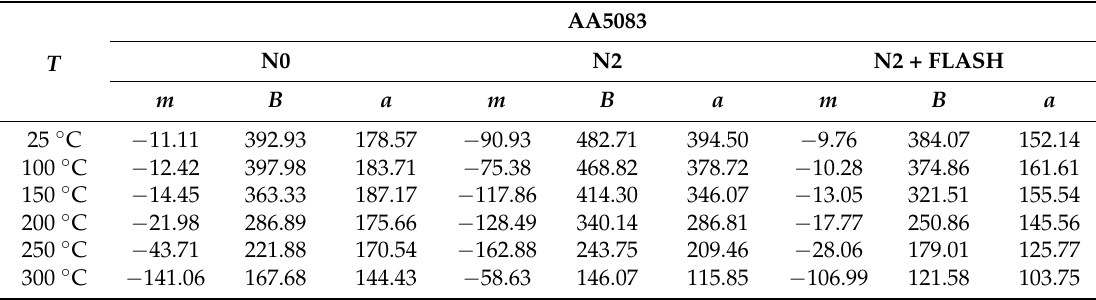
Table 10. Values for Voce’s parameters in the case of